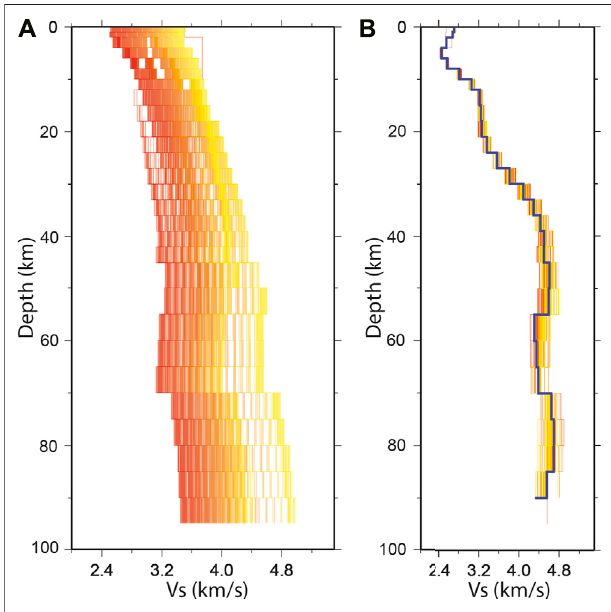
FIGURE 6 | (A) Initial 1-D models used for inversion and (B) corresponding inverted 1-D models. Blue line indicates the model chosen for further